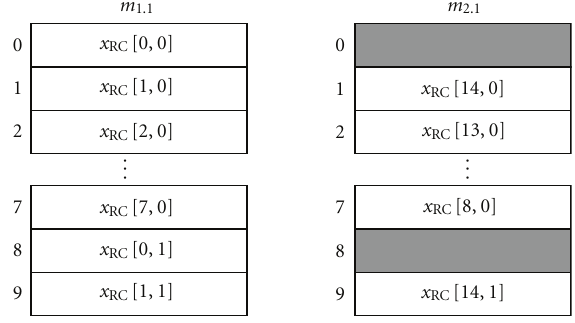
Figure 7: Memory organization before FFT-15 (RC order).